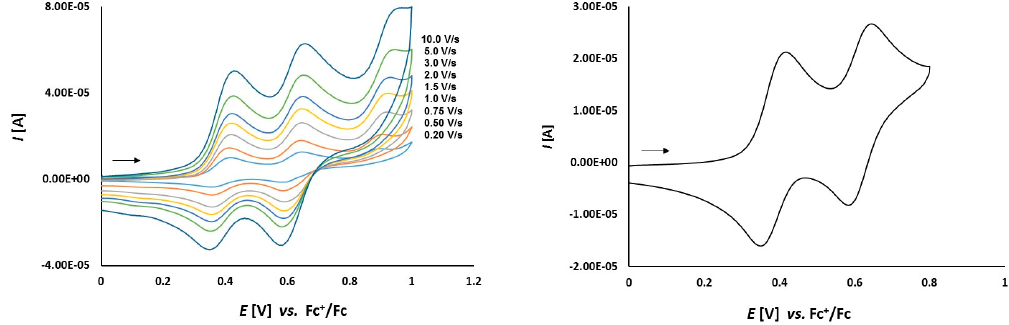
Figure 5. Cyclic voltammetry of complex 1a (1.0 mmol / L) in CH 2 Cl 2 -[ n Bu 4 N][BF 4 ] (0.1 m / L) solutions at various scan rates ( left ) and at v = 0.75 V / s ( right ). The potentials E are given in V and referenced to the Fc + / Fc couple. The arrows indicate the scan direction.